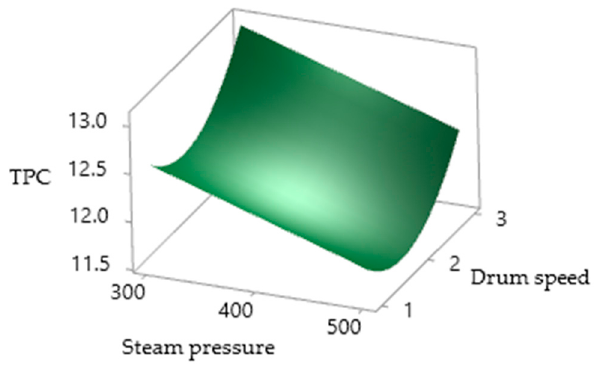
Figure 6. Surface plots of the drum-dried PSPP, TPC as affected by SP and